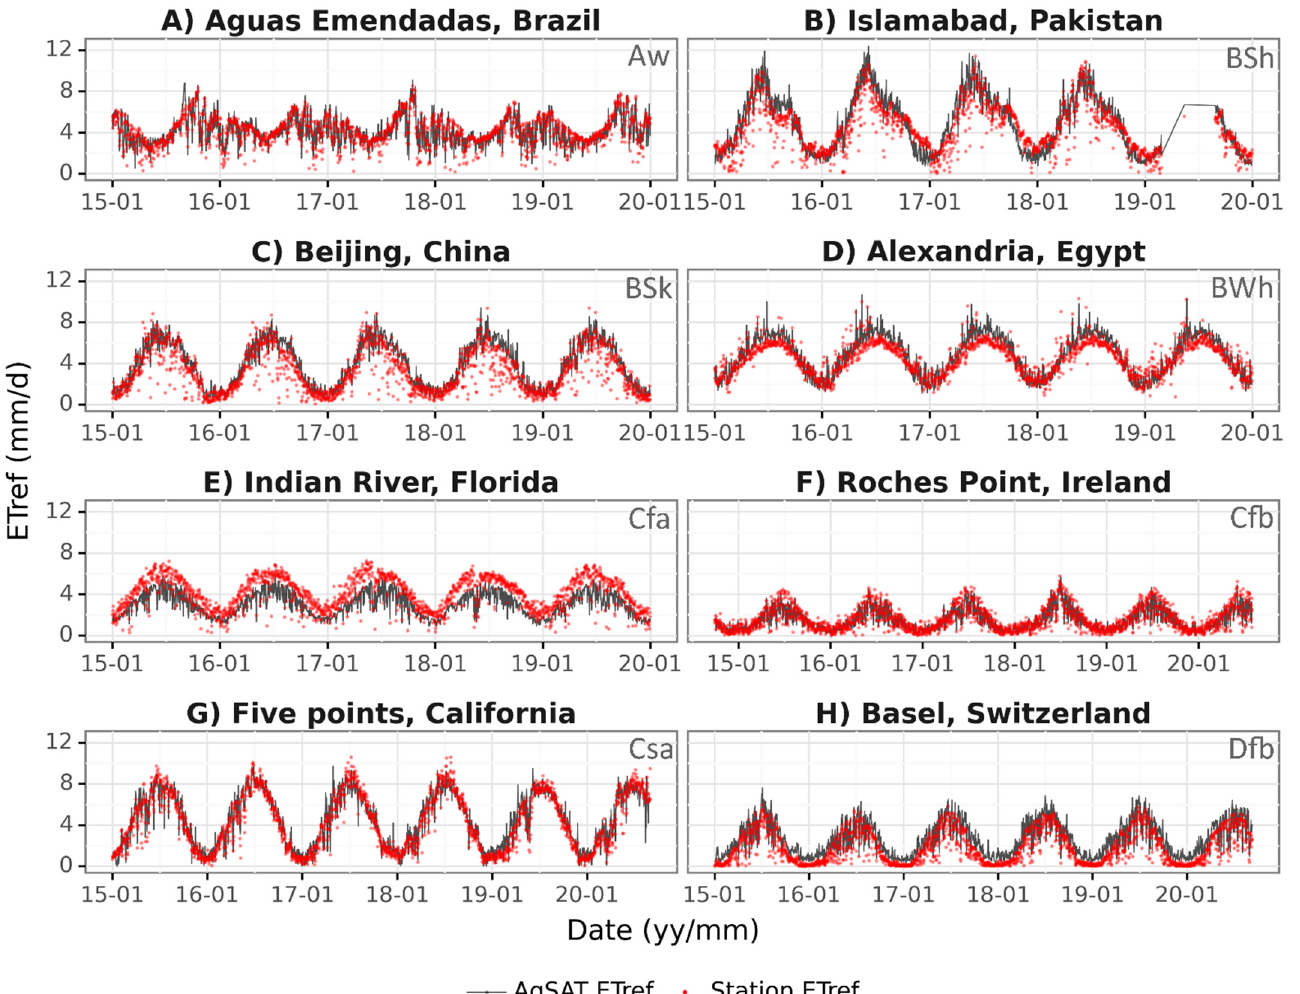
Figure 7. Daily AgSAT and station ETref over the study period of eight weather stations selected from each climate groups: Aw: wet tropical-savanna, BSk: cold semi-arid, Cfa: humid subtropical, Dfb: humid continental, BSh: hot semi-arid, Cfb: oceanic, Csa: Mediterranean, and BWh: arid-desert-hot. The station ETref is in red and AgSAT ETref is in black.